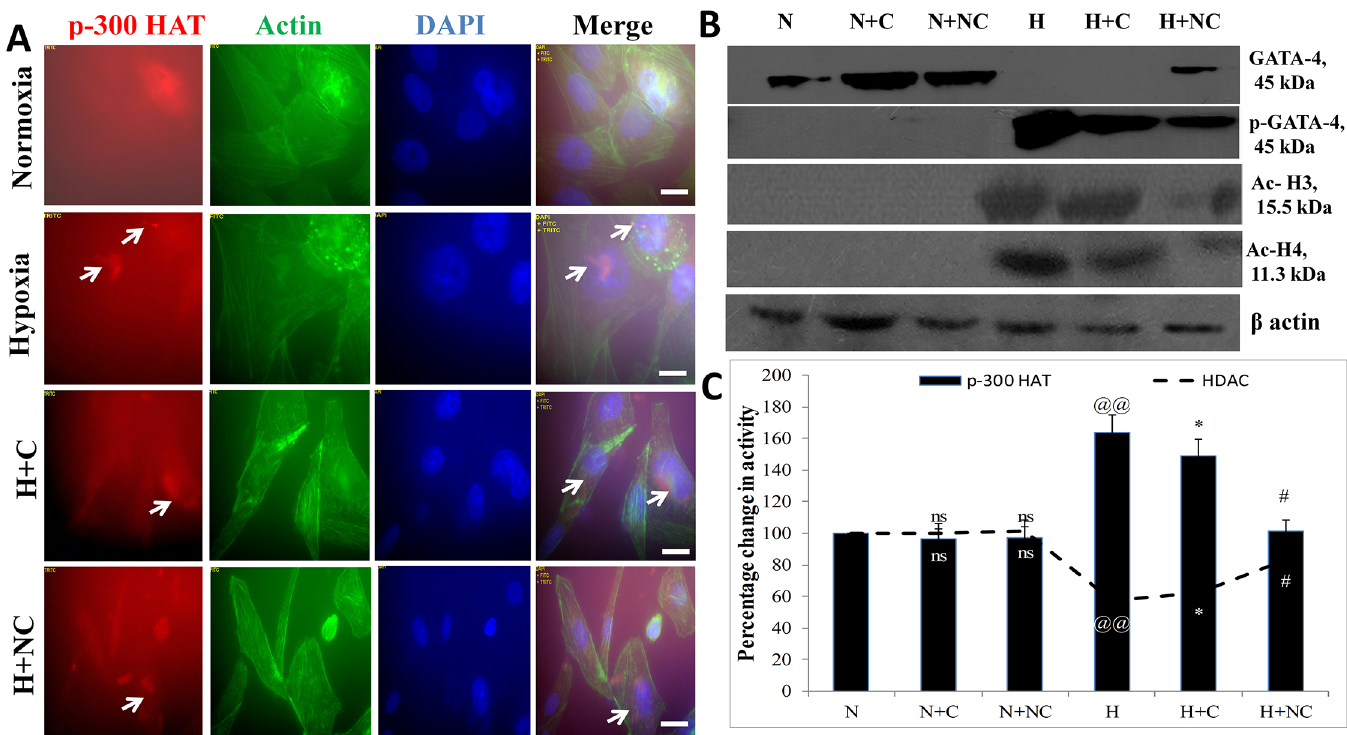
Fig 3. Effect of nanocurcumin on p-300 HAT and HDAC activities in HVCM cells under hypoxia: Histone acetylation by p-300 was up-regulated with a corresponding decline in HDAC activity in cardiomyocytes under hypoxia depicting that hypoxia induced hypertrophy dependent upon p-300 HAT and HDAC activity (A and C). Nanocurcumin treatment significantly down-regulated p-300 HAT and up-regulated HDAC activity in HVCM cells under hypoxia compared to cells exposed to hypoxia only. This was further confirmed by western blot analysis of GATA-4 and p-GATA-4 levels along with acetylated histone 3 and 4 (B). However, curcumin treatment did not prevent histone acetylation under hypoxia. Also, nanocurcumin or curcumin treated cells did not show change in p- 300 HAT activity under normoxia. Values are mean ± SD, significant values represented as @@ p (cid:1) 0.01 vs normoxia, * p (cid:1) 0.05 vs hypoxia and # p (cid:1) 0.01 vs hypoxia. Non-significant changes are depicted as ns. Scale bar represents 50 μ